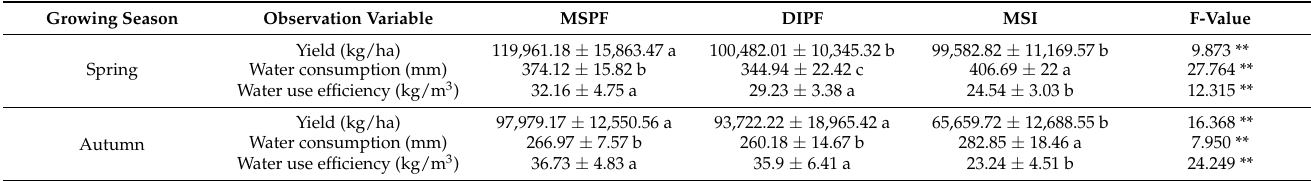
Table 3. Effects of different irrigation strategies and PF mulching on the fruit yield and water use efficiency of